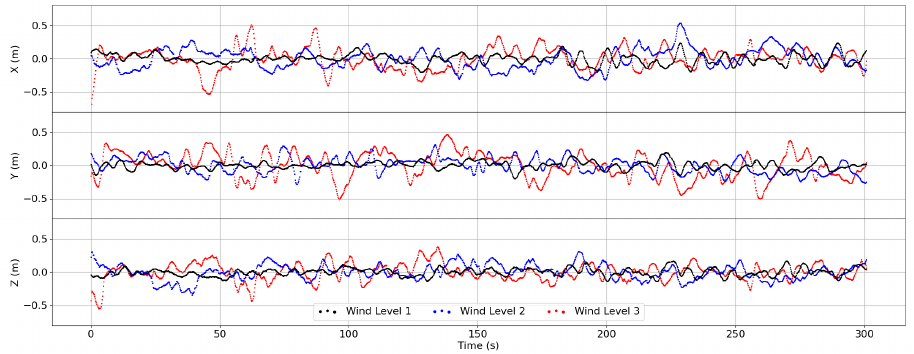
Figure 7. Comparison of DJI M600 movements.